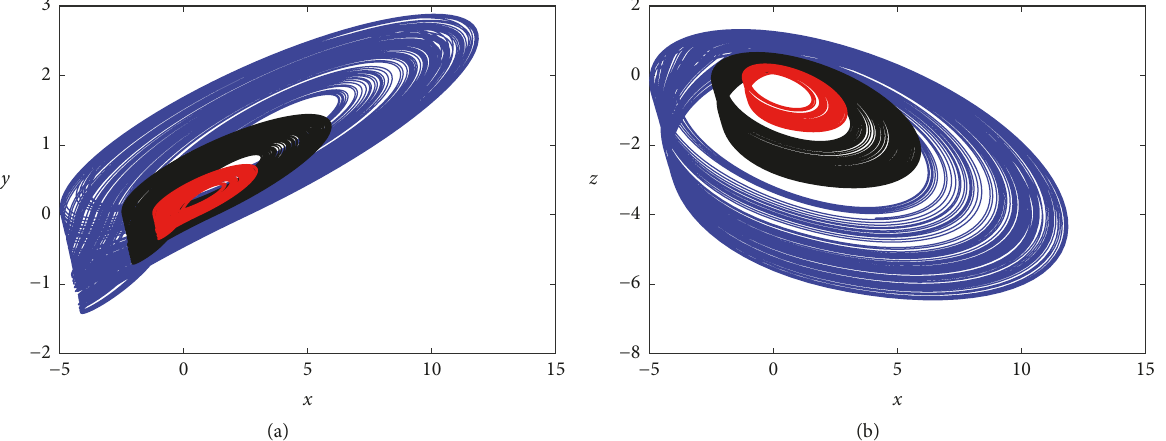
Figure 7: Controllable chaotic attractors in (a) 𝑥 - 𝑦 plane and (b) 𝑥 - 𝑧 plane when varying the control parameter 𝑘 𝑥𝑦𝑧 : black color for 𝑘 𝑥𝑦𝑧 = 1 , blue color for 𝑘 𝑥𝑦𝑧 = 2 , and red color for 𝑘 𝑥𝑦𝑧 = 0.5